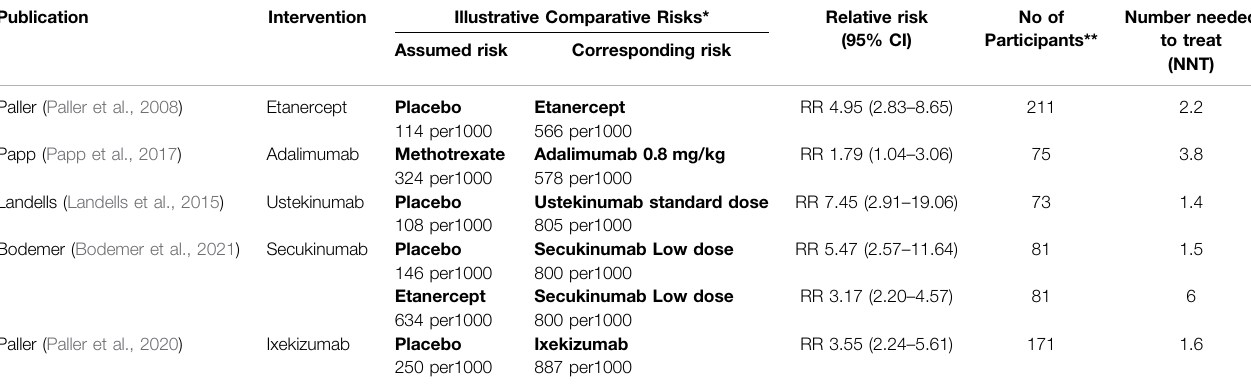
TABLE 3 | Ef fi cacy outcome: PASI 75. Active treatment (intervention) compared to placebo or active comparator (methotrexate,